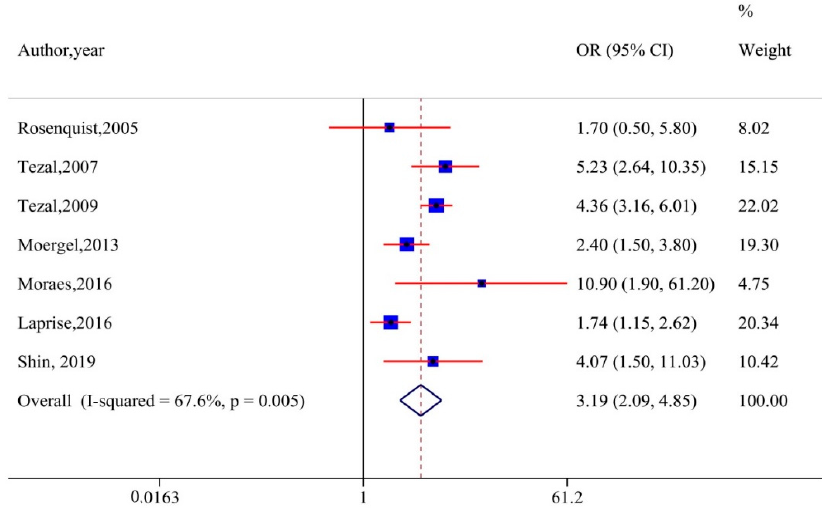
Figure 3. Sensitivity analysis plot excluding studies that did not adjust for smoking and alcohol.